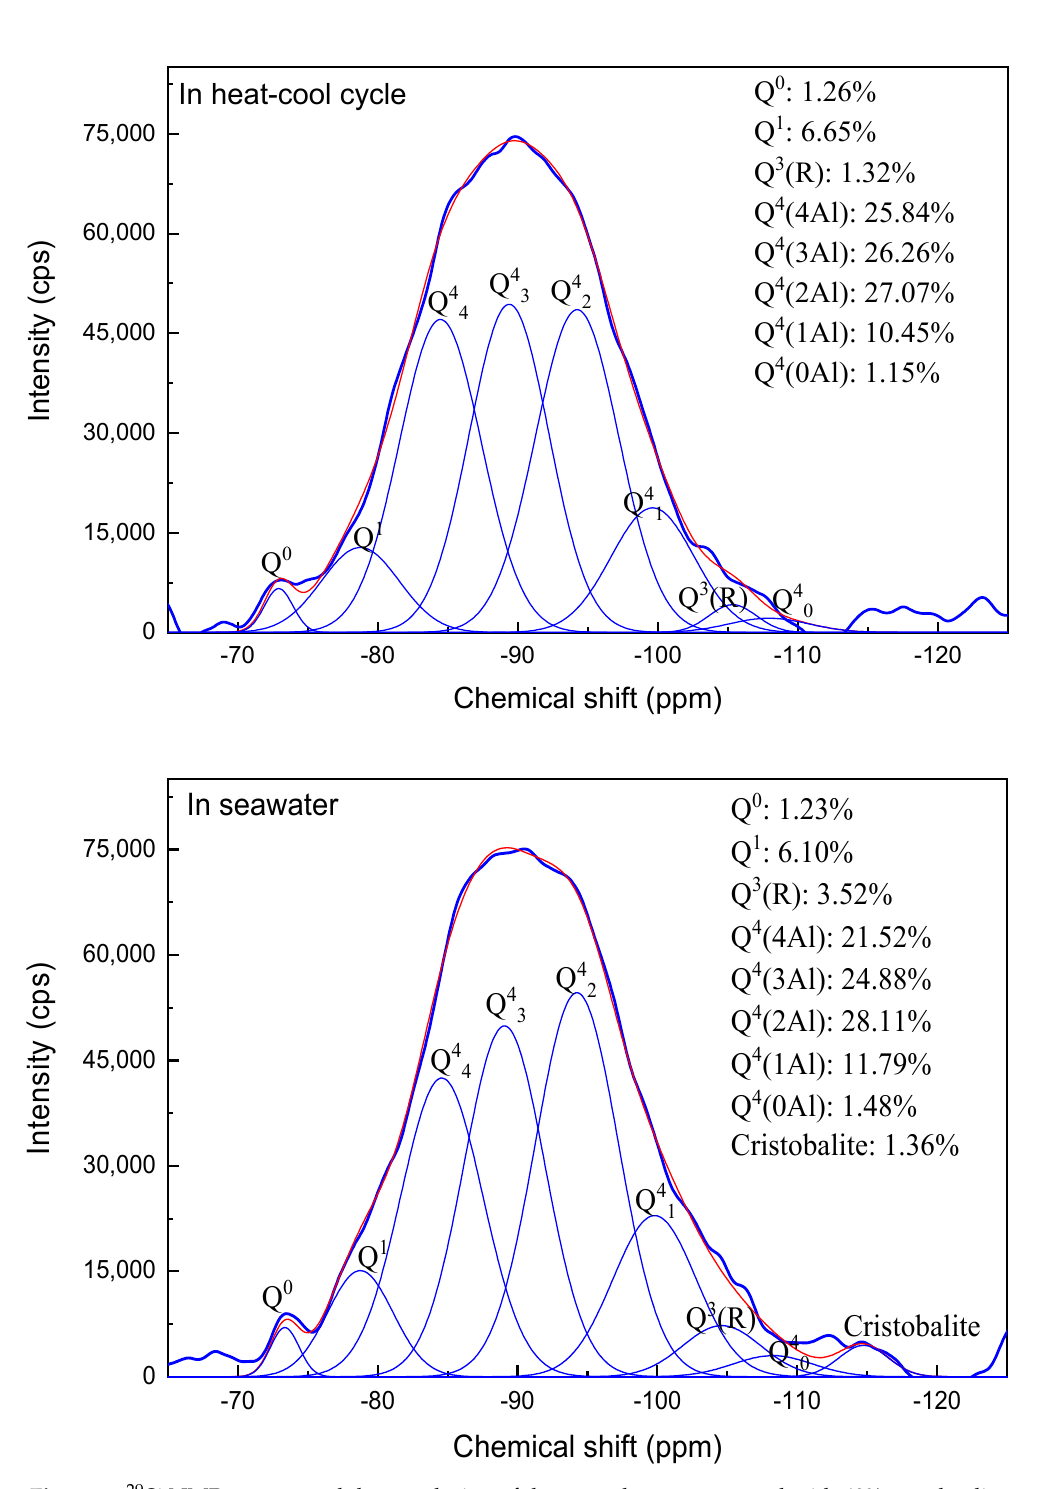
Figure 6. 29 Si NMR spectra and deconvolution of the geopolymers prepared with 60% metakaolin.